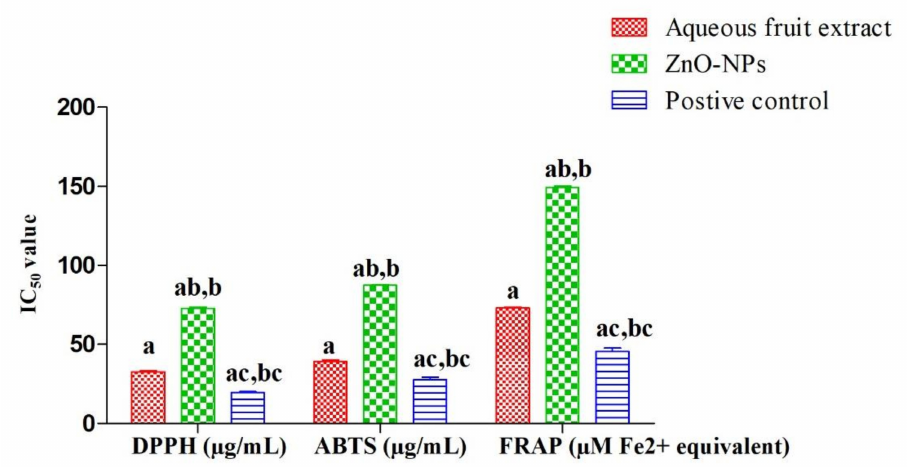
Figure 8. In vitro antioxidant potential (IC 50 value) of zinc oxide nanoparticles and fruit extract [Different superscript showed significant ( p < 0.05) difference between (a) fruit extract, (b) ZnO-NPs and (c) positive control between plant extract and